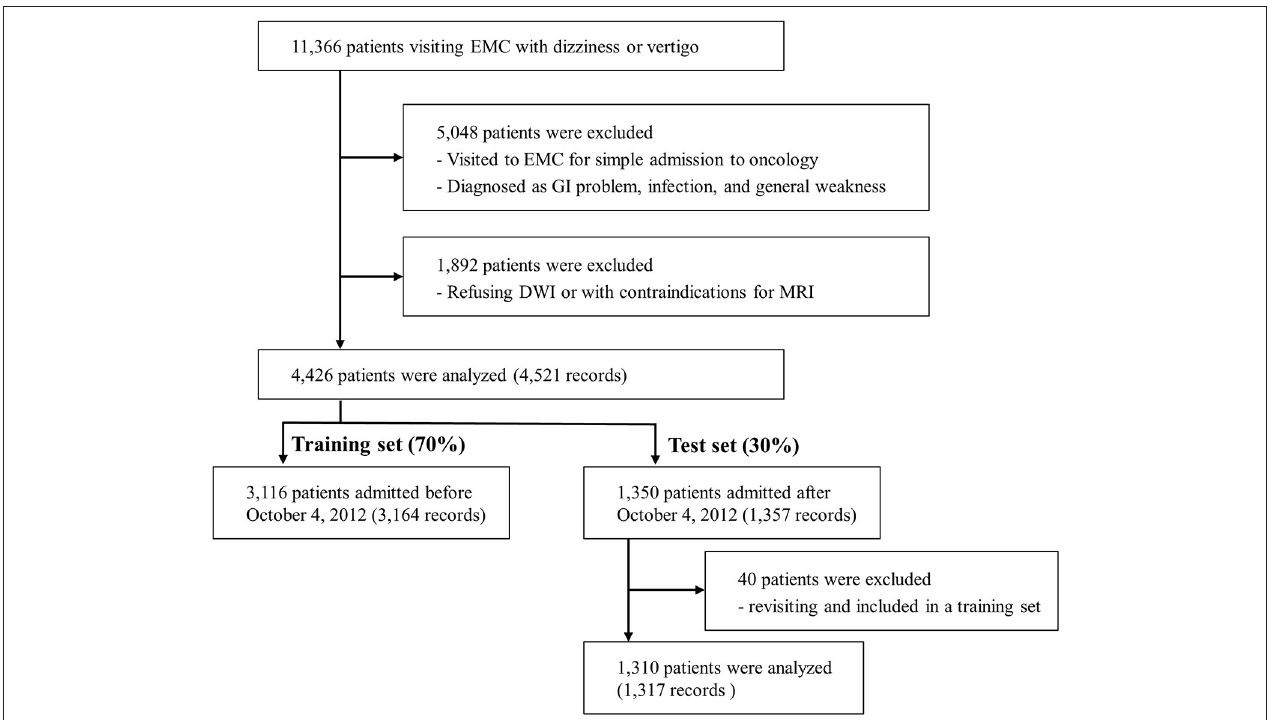
FIGURE 1 | Flow diagram. EMC, emergency medical center; GI, gastrointestinal; DWI, Diffusion-weighted imaging; MRI, Magnetic resonance imaging. TABLE 1 | Baseline characteristics of the records of the enrolled patients with central and non-central dizziness. Central dizziness † ( n = 414) Non-central dizziness † ( n =